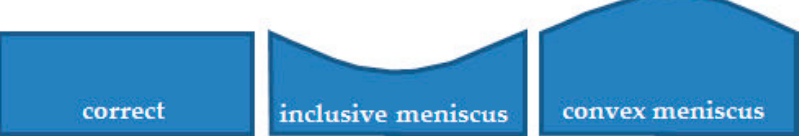
Figure 3. The issue of a convex and concave meniscus, casting in silicone.